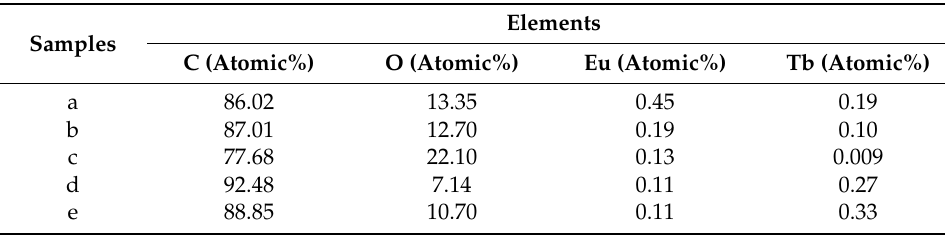
Table 2. Elemental analyses of the BCP-Ln 3+ -Phen complex a–e. Elements Samples C (Atomic%) O (Atomic%) Eu (Atomic%) Tb